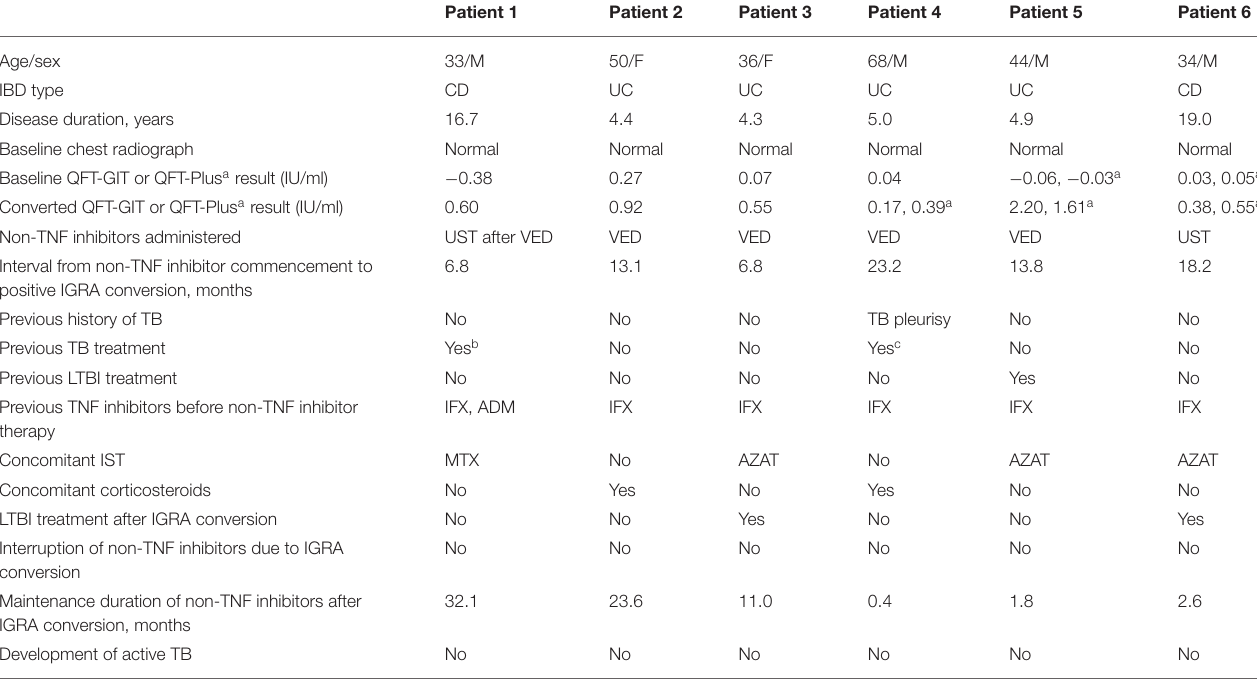
TABLE 2 | Demographic and clinical characteristics of IGRA converters among IBD patients treated with non-TNF